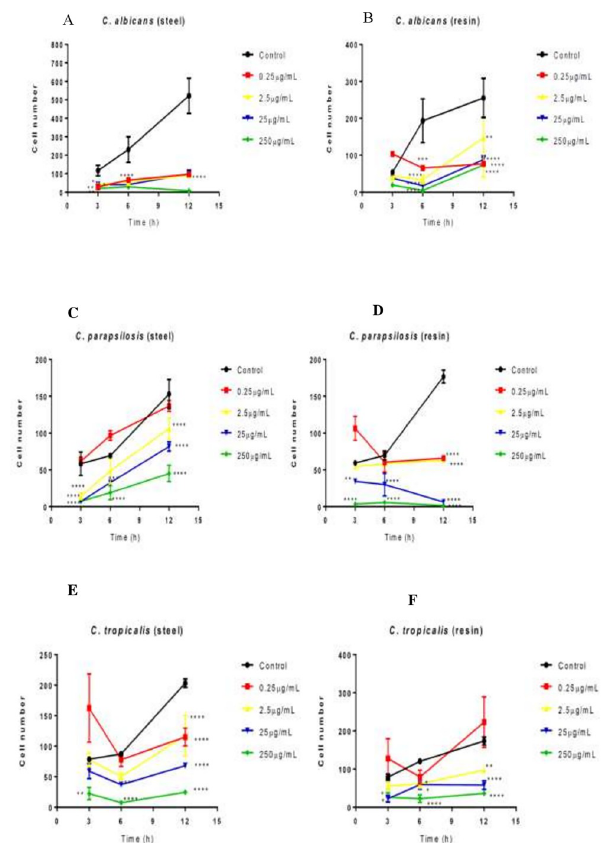
Fig 3. Effect of green propolis extract on the adhesion of C . albicans , C . parapsilosis , and C . tropicalis on the surfaces of dental materials (acrylic resin and steel). Effect of extract against Candida spp. according to time and material. � p < 0.05; �� p < 0.01; ��� p < 0.001; � p < 0.0001.